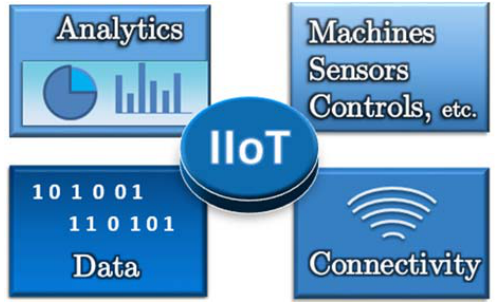
Figure 7. Industrial internet of things (IIoT) framework that utilizes connectivity, data, and analytic tools to communicate effectively with